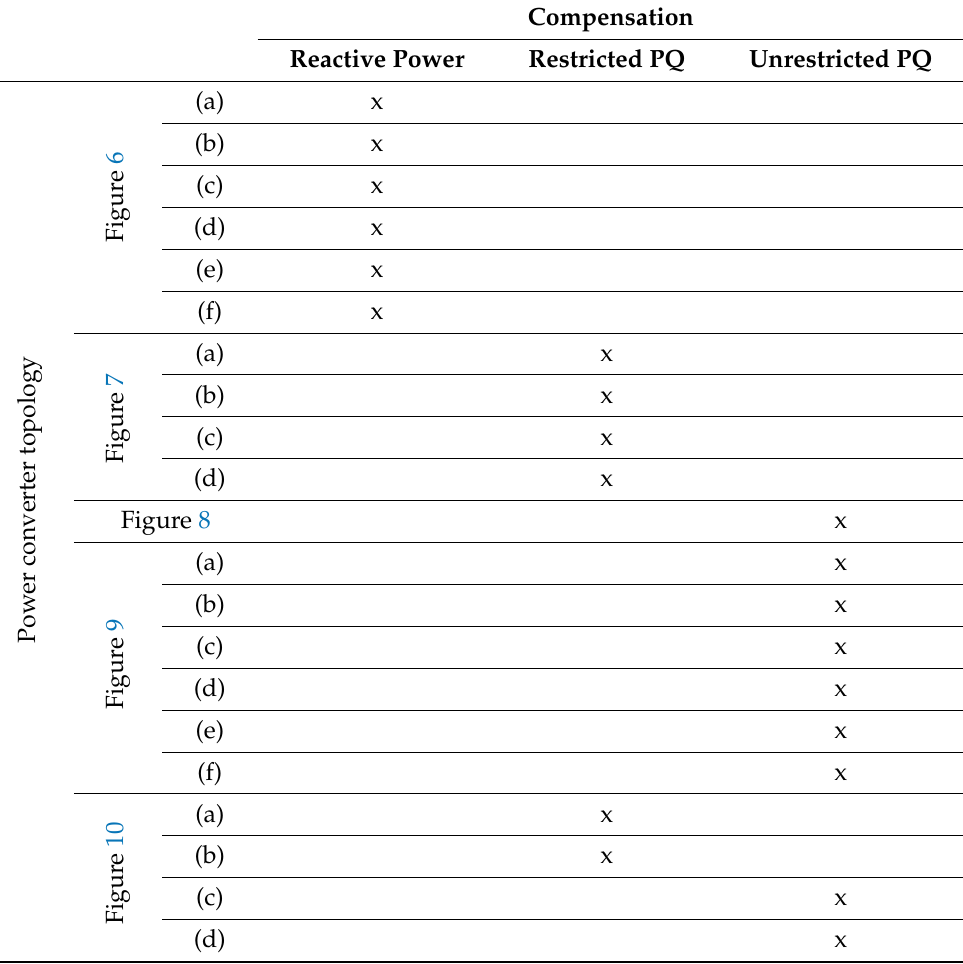
Table 3. Power converters operating